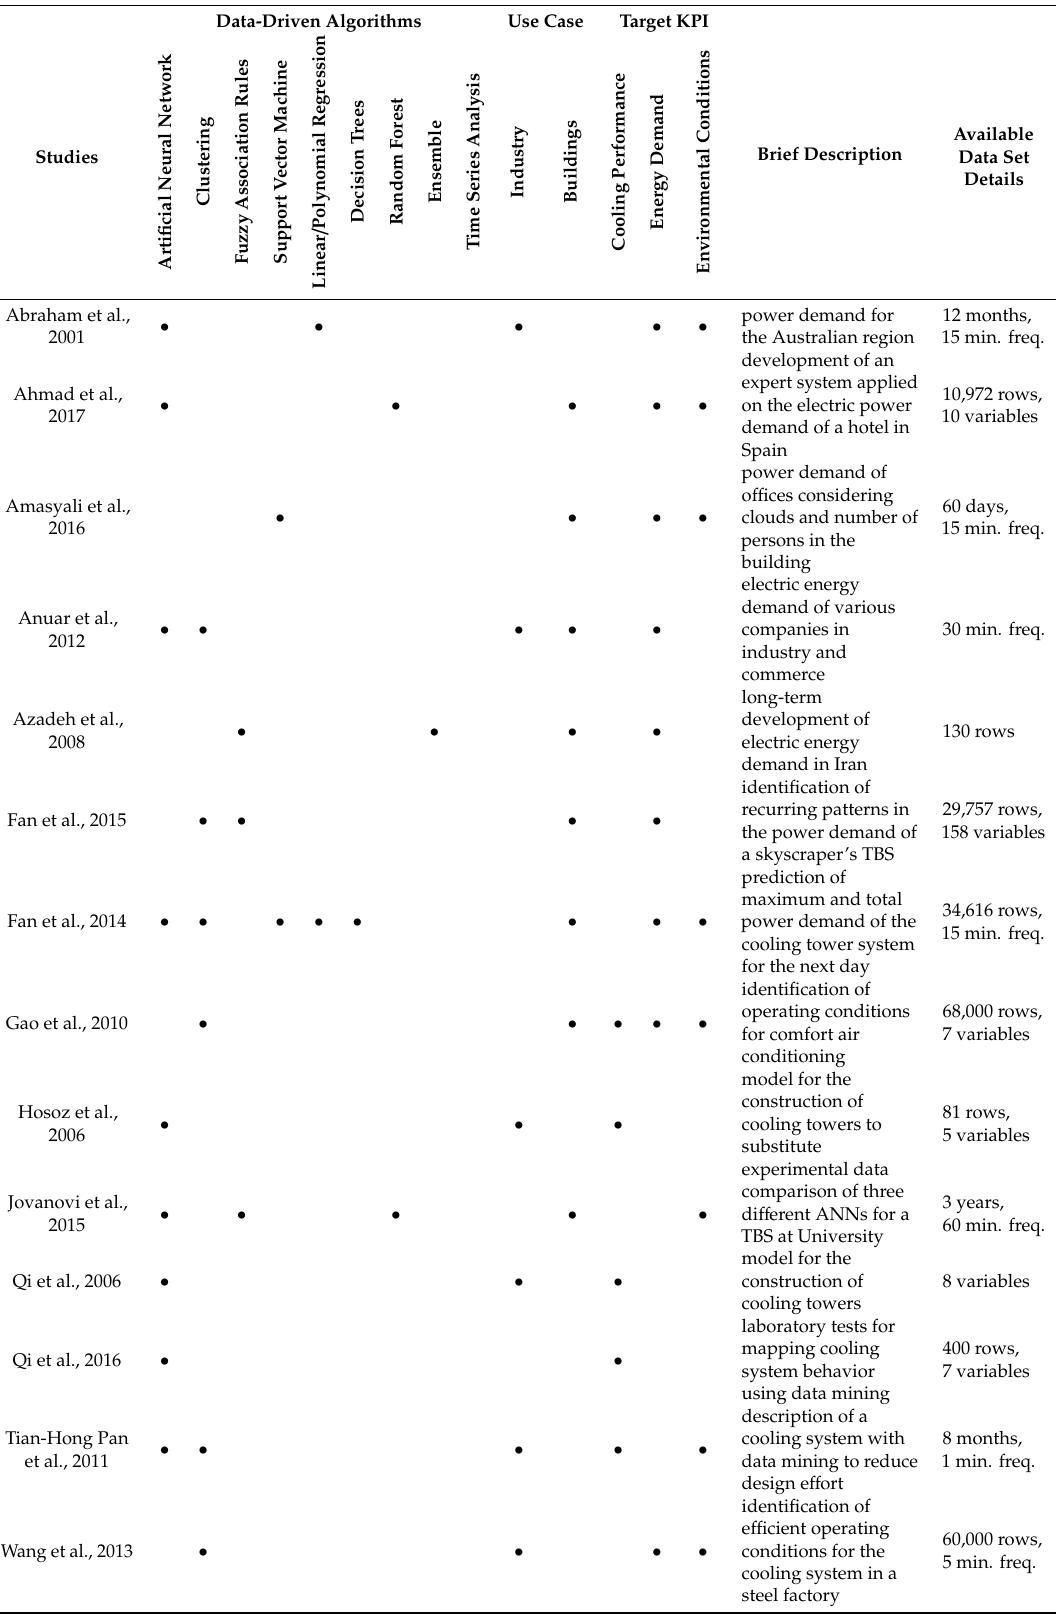
Table 1. Overview of relevant research addressing data-driven approaches for cooling tower systems.